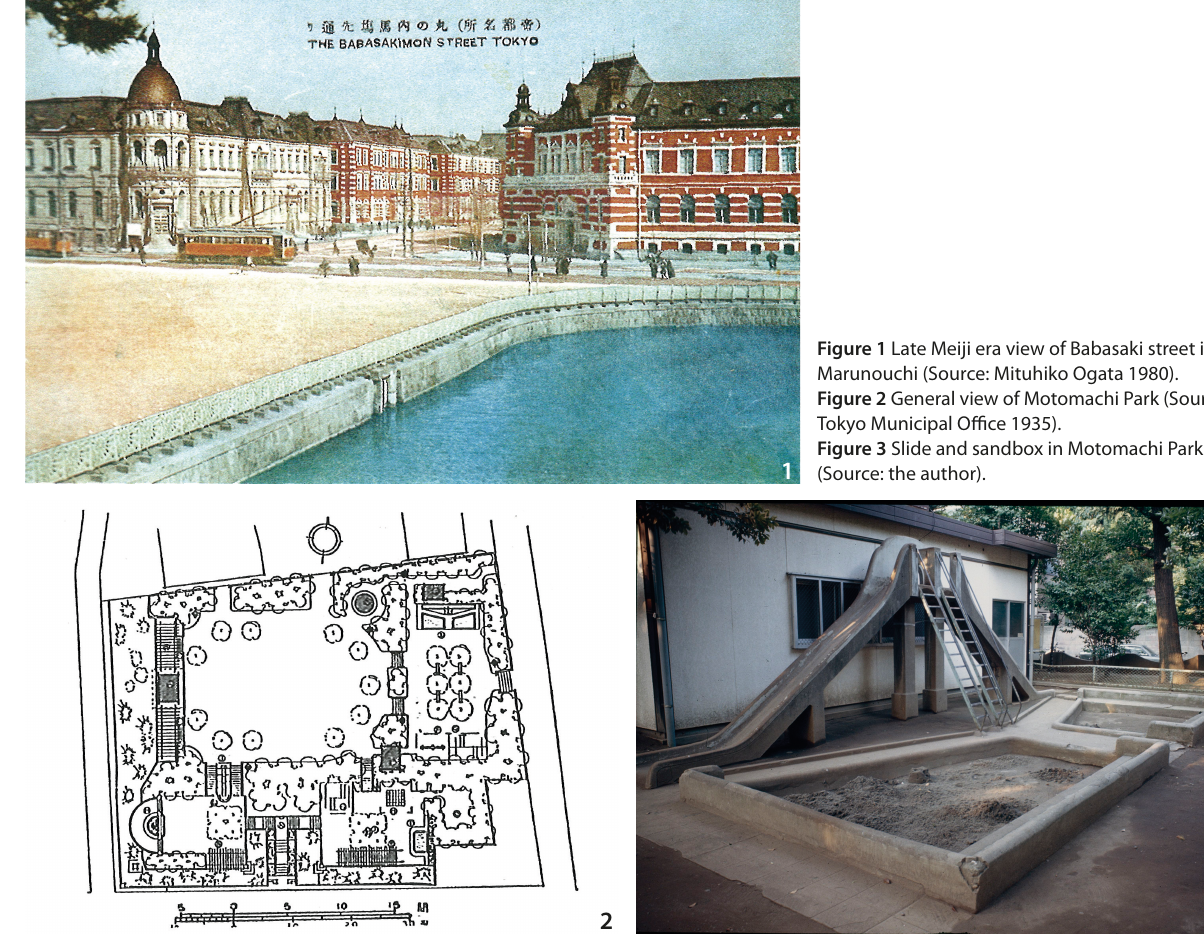
Figure 1 Late Meiji era view of Babasaki street in Marunouchi (Source: Mituhiko Ogata 1980). Figure 2 General view of Motomachi Park